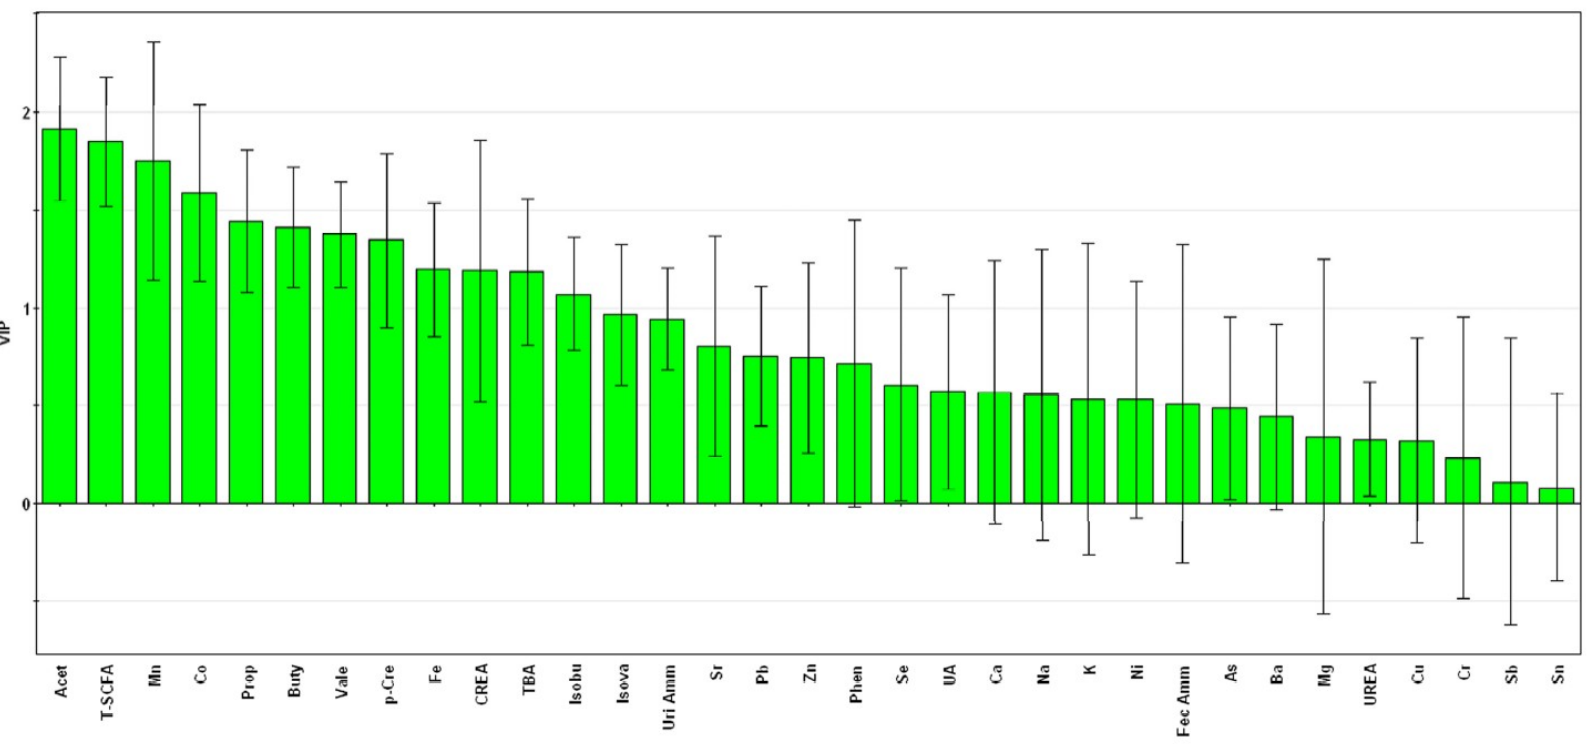
Figure 4. Variable importance in the projection (VIP) plot from the partial least squares-discriminant analysis of overall indexes including the metabolites and elements in the three groups. Variables for which the VIP ± 95% confidence interval (CI) exceeds 1 are designated as significant differential components, including acetic acid, total SCFA, Mn, Co, propionic acid, butyric acid and valeric acid. Acet, acetic acid; Prop, propionic acid; Buty, butyric acid; Isobu, isobutyric acid; Vale, valeric acid; Isova, isovaleric acid; T-SCFA, total SCFA; TBA, total bile acids; Phen, phenol; p -Cre, p -cresol; UA, uric acid; CREA, creatinine; Fec Amm, fecal ammonia; Uri Amm, urinary ammonia.